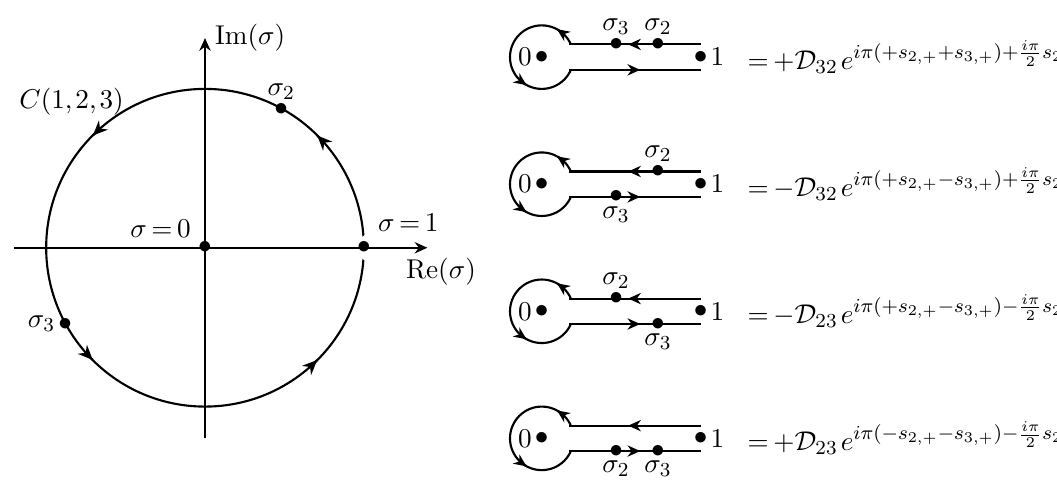
Figure 5 . In the (cid:27) j = e 2 (cid:25)iz j variables, the integration contour C (1 ; 2 ; 3) is the unit circle in the left panel, where the phases of (cid:27) 2 and (cid:27) 3 are ordered according to z 2 < z 3 . Similar to (cid:12)gure 4,